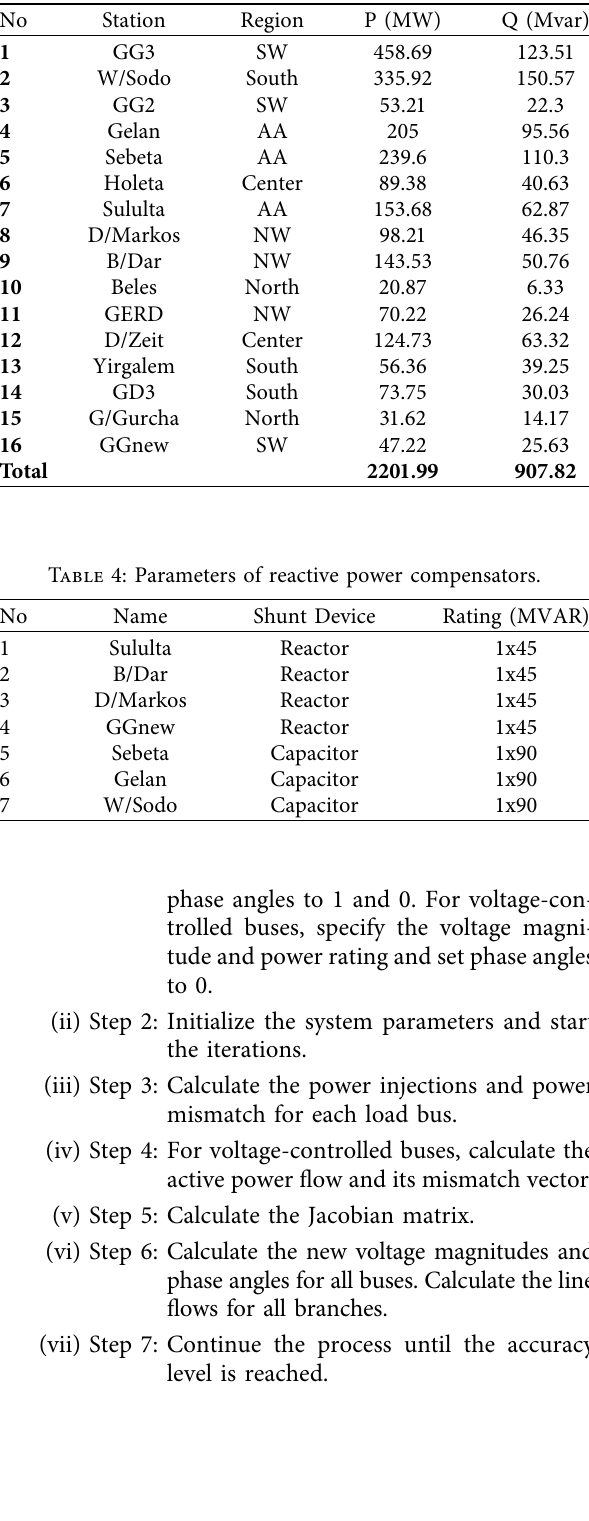
Table 3: Base load data as of 2021.